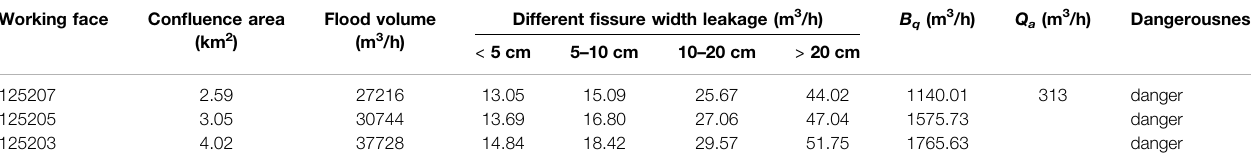
TABLE 4 | The amount of water leakage and the risk degree. Working face